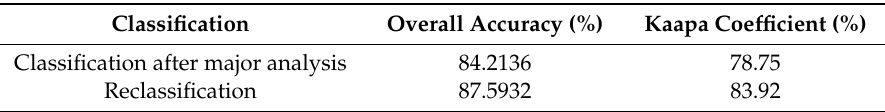
Table 5. Classification accuracy by confusion matrix